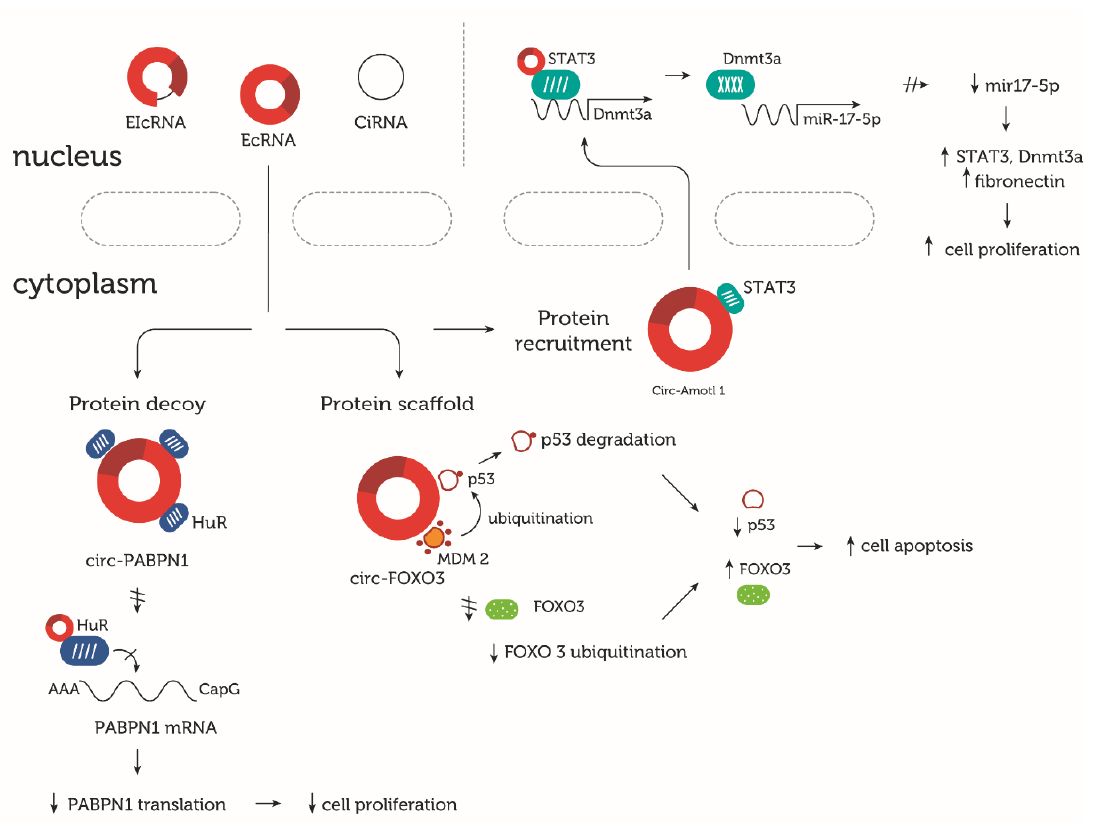
Figure 3. circRNAs acting as decoy, scaffold, and recruiter molecules. Depending on the conditions, some circRNAs may exert several activities. circ-PABPN1 can decoy the human antigen R (HuR) protein in HeLa cells, thereby preventing HuR from attaching to PABPN1 mRNA, inhibiting PABN1 mRNA translation and resulting in decreased cell proliferation [134]. The circ-FOXO3 scaffold p53 and MDM2 cause ubiquitin-dependent p53 degradation and, at the same time, decrease FOXO3 ubiquitination. Reduced p53 and increased FOXO3 levels result in enhanced cell apoptosis in cancer cell lines [132]. circ-Amolt1 recruits STAT3 and changes its location from the cytoplasm back to the nucleus in skin fibroblasts. The circ-Amotl1-STAT3 complex promotes Dnmt3a transcription, which in turn inhibits the miR17-5p production. Decreased miR17-5p results in STAT3, Dnmt3a, and fibronectin overexpression, thus activating cell proliferation, which is critical in the wound healing process [130].